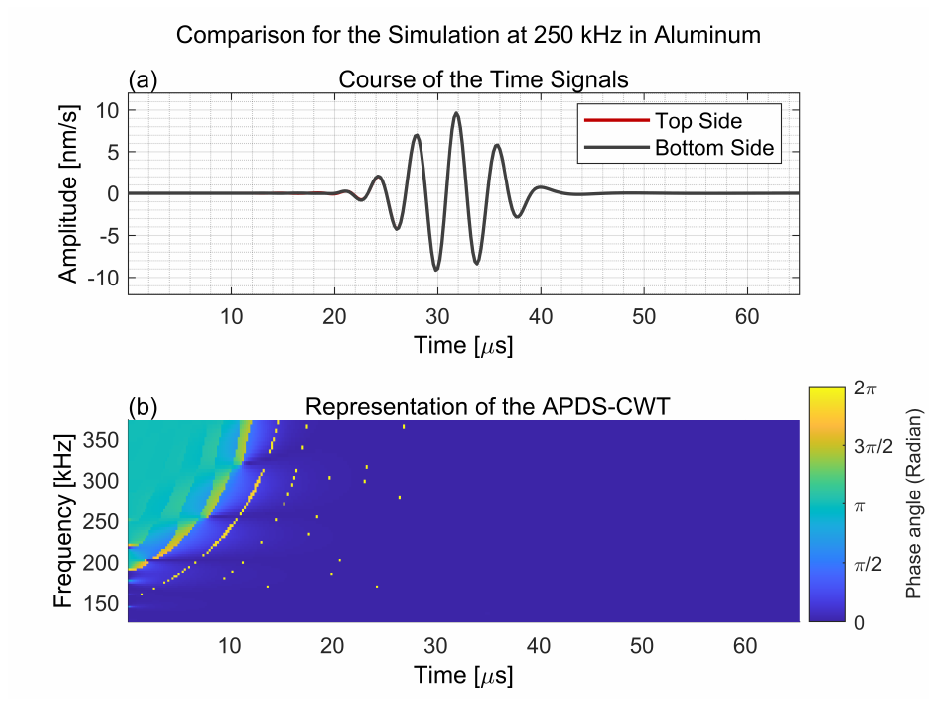
Figure 12. Juxtaposed time signals and the APDS-CWT in aluminum at 250kHz. ( a ) Time domain: The course of the time signals. ( b ) Frequency domain: The